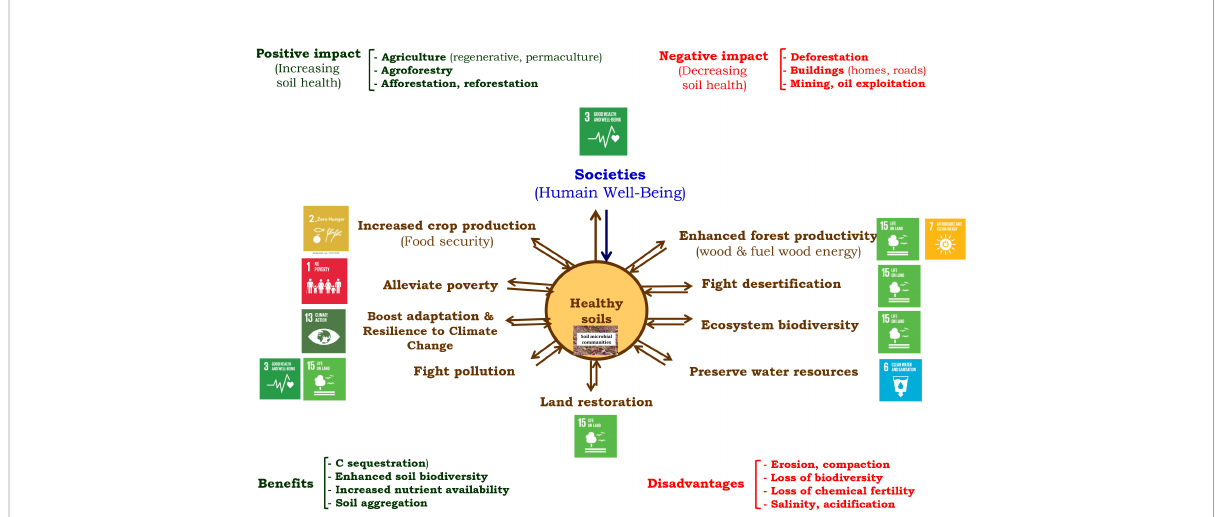
FIGURE 3 Impacts of human activities on some direct bene fi ts and disadvantages on soil health. Healthy soil is linked to seven out of 17 sustainable development goals (SDG) of the United Nations (Sustainable Development Goals: 17 Goals to Transform our WorldUnited Nations): SDG 1: end poverty in all its forms everywhere; SDG 2: end hunger, achieve food security, improve nutrition, and promote sustainable agriculture; SDG 3: ensure healthy lives and promote well-being for all at all ages; SDG 6: ensure availability and sustainable management of water and sanitation for all; SDG 7: ensure access to affordable, reliable, sustainable, and modern energy for all; SDG 13: take urgent action to combat climate change and its impacts; and SDG 15: protect, restore, and promote sustainable use of terrestrial ecosystems; sustainably manage forests; combat deserti fi cation; halt and reverse land degradation; and halt biodiversity